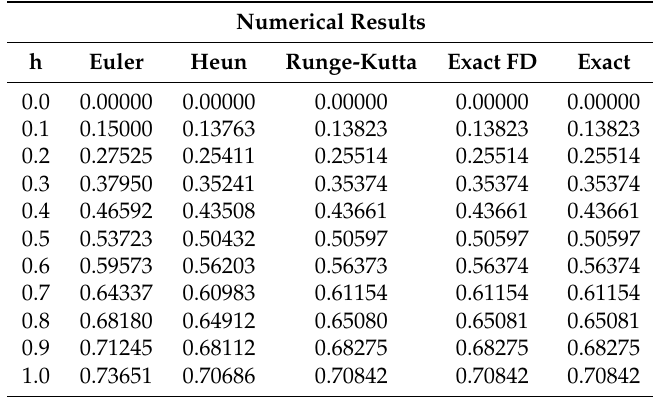
Table 2. The numerical results for the extravascular administration